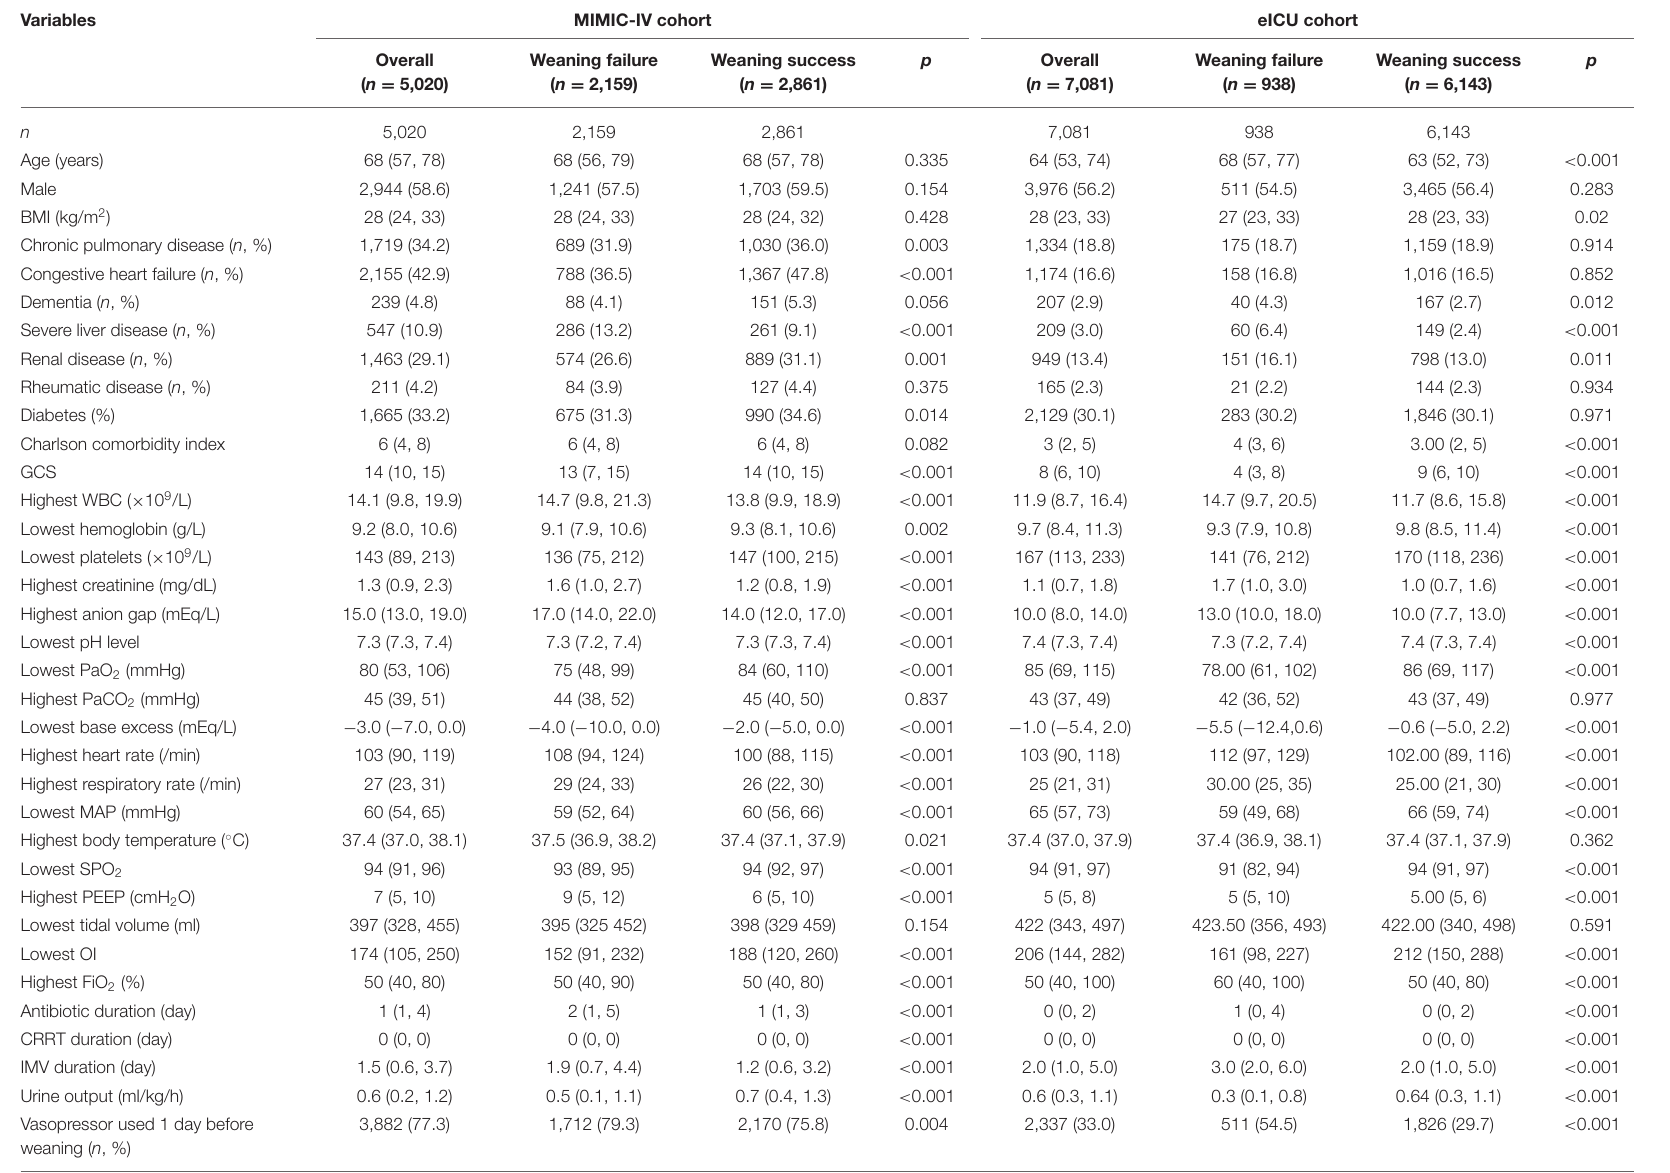
TABLE 1 | Baseline characteristics of the MIMIC-IV and eICU